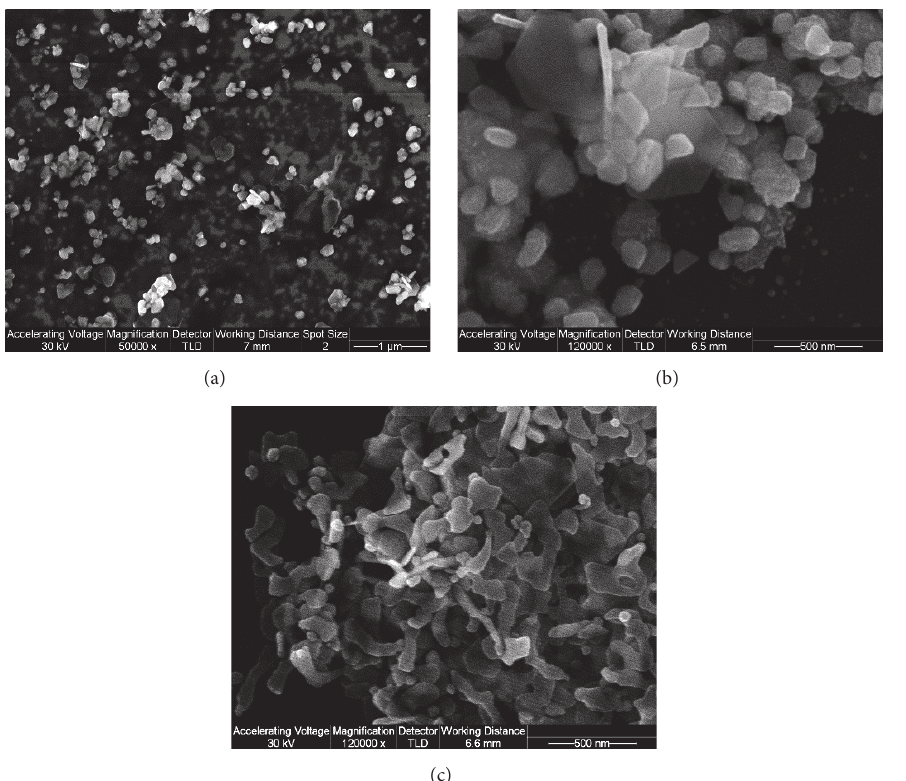
Figure 3: SEM images showing results from gold nanoparticle synthesis with variances in the temperature at which the synthesis was performed. (a) 15 ∘ C bath, (b) room temperature, and (c) 45 ∘ C bath.